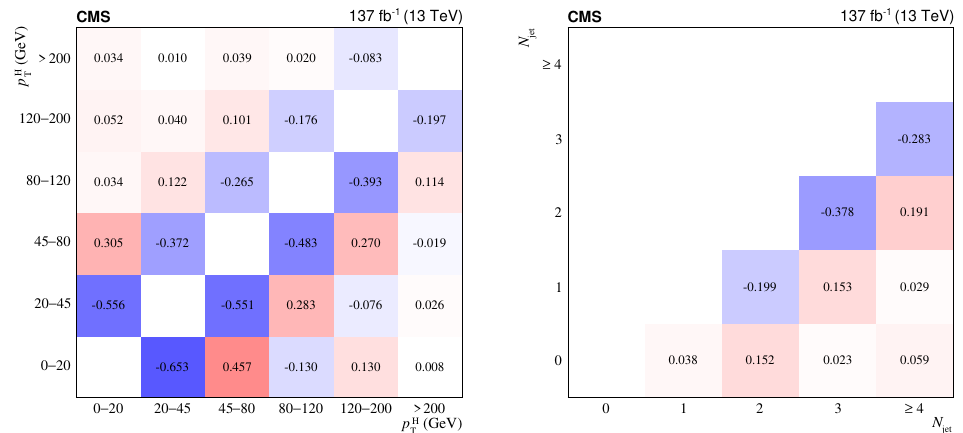
(left) and N jet T